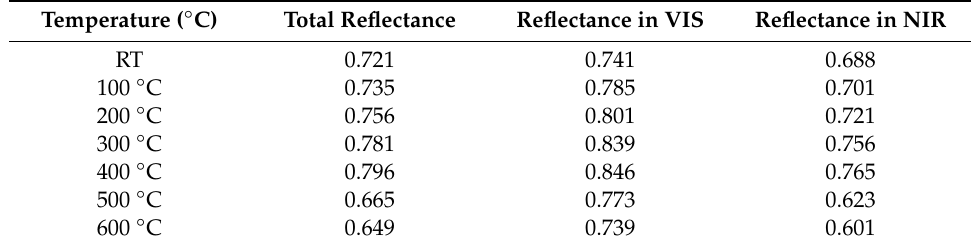
Table 3. The reflectance of coatings filled with shell powders calcined at di ff erent temperatures. Temperature ( ◦ C) Total Reflectance Reflectance in